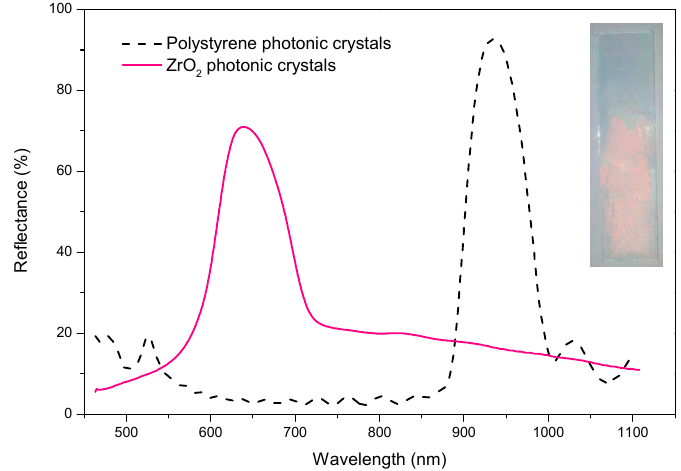
Figure 4. Reflectance spectra for polystyrene and ZrO 2 3DPCs and the visual appearance of ZrO 2 3DPCs (insert).